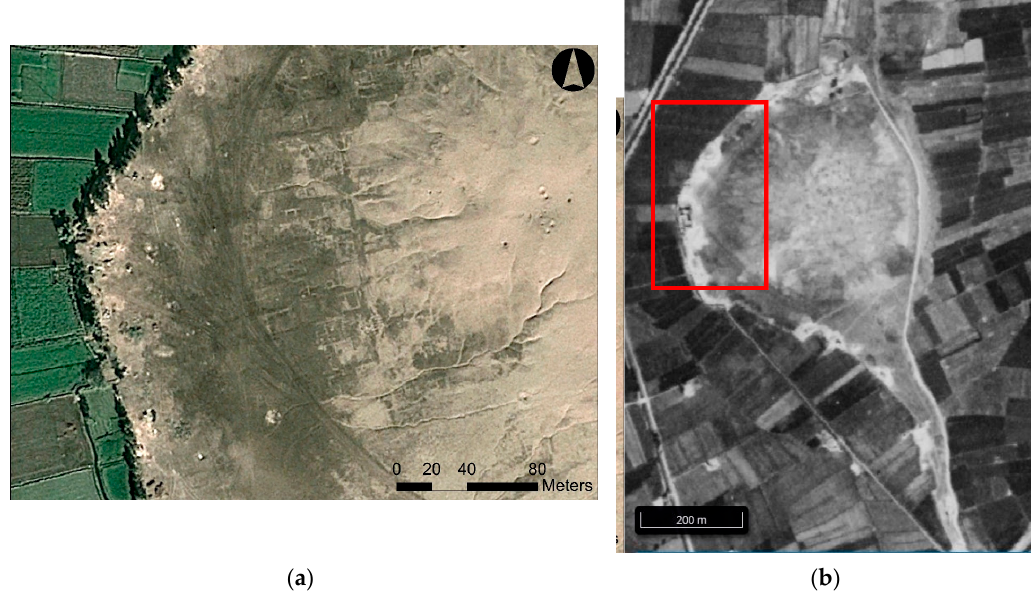
Figure 14. ( a ) The site of Kom el Arab. Image courtesy Google Earth; ( b ) 1968 CORONA image. The area of image ( a ) is in the red box. Image courtesy of the Center for Advanced Spatial Technologies, University of Arkansas/U.S. Geological Survey.